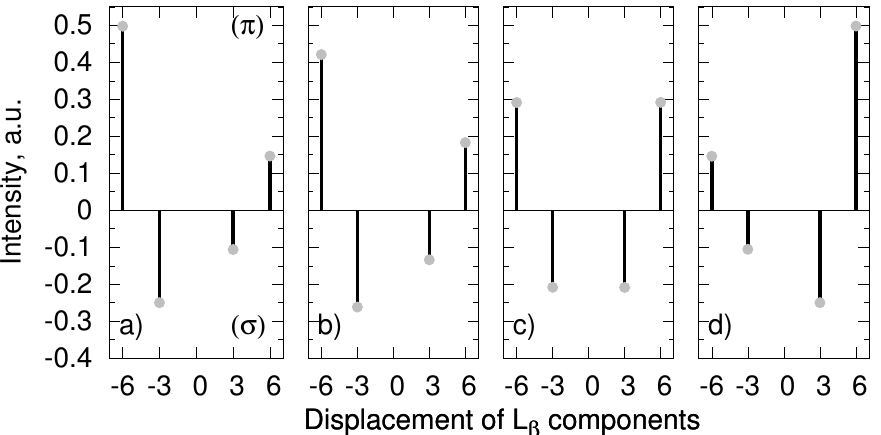
Figure 5. The Stark effect for the Lyman- β line excited by proton impact at a collision energy of 50 keV/u and by electrons with temperature of 3 keV. For the statistical intensities the ratio between components σ ± : π ± = 25:25, and for the dynamical intensities the ratio is 23:27. Other notations are 3 6 the same as in Figure